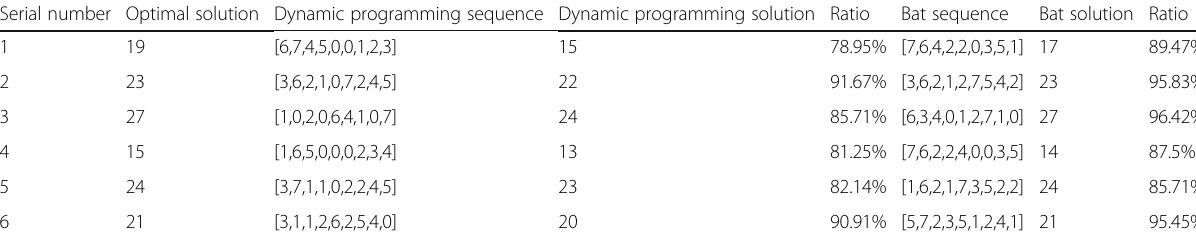
Table 3 Results of dynamic programming algorithm and discrete bat algorithm Serial number Optimal solution Dynamic programming sequence Dynamic programming solution Ratio